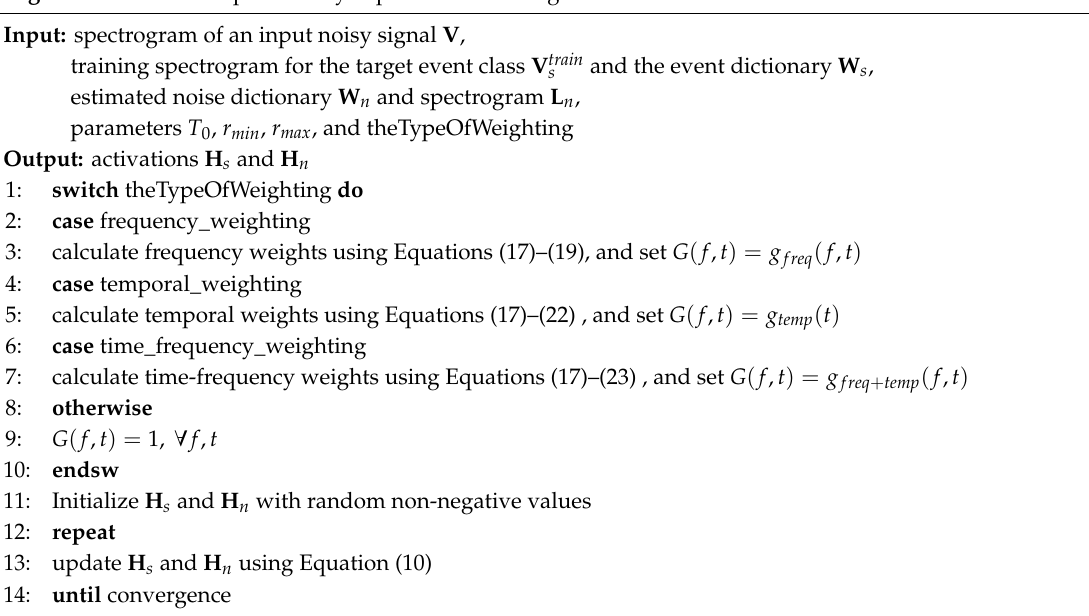
Algorithm 2. Source separation by supervised and weighted